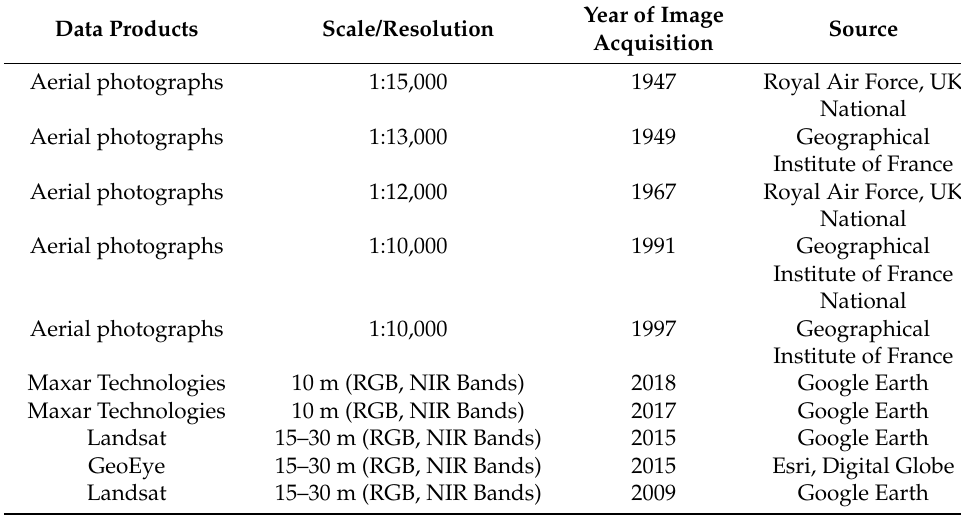
Table 1. Data products and its